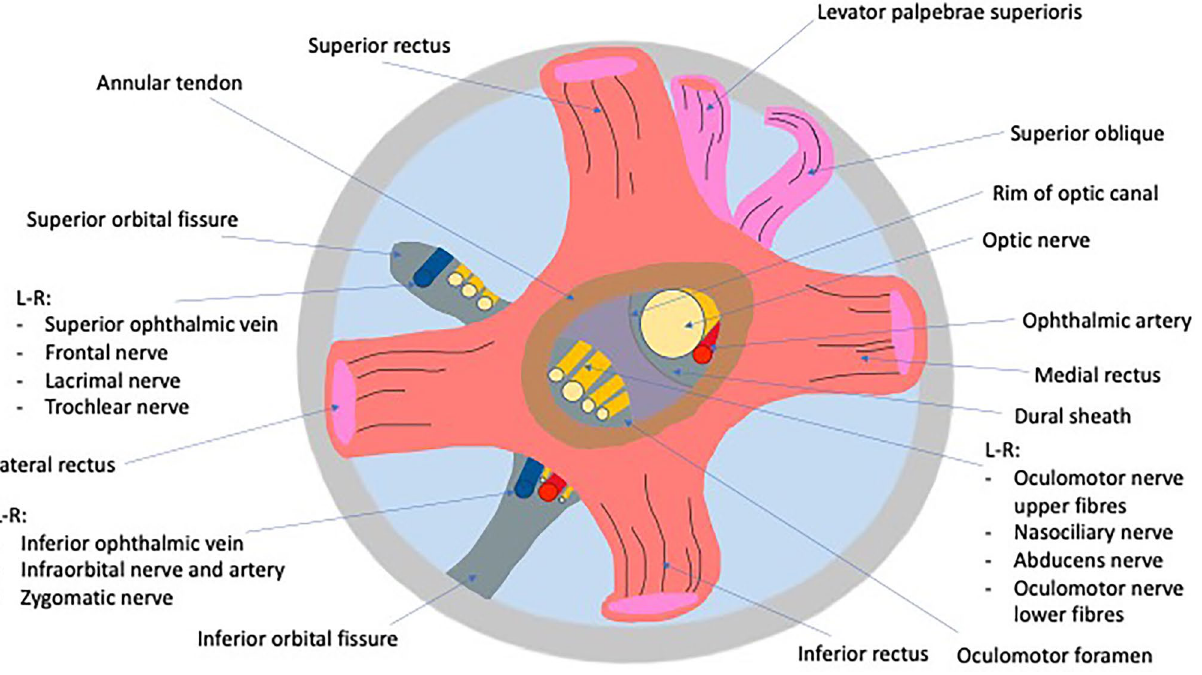
Figure 1. Diagrammatic representation of the anatomy of the orbital